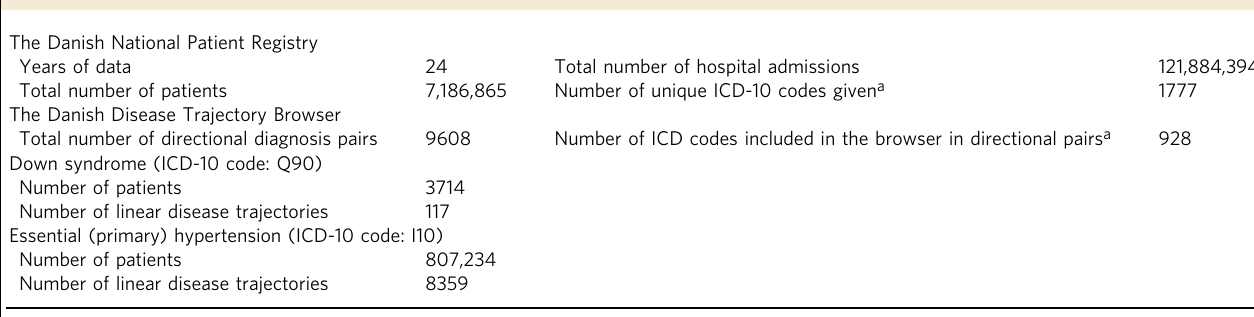
displays search results either as linear disease trajectories or as a disease trajectory network (e.g. Figs. 2 and 3). For quick queries and overview, it is recommended that users turn on the network view, which will be fastest and also appropriate for subsequent adjustment of search fi lters. In DS ( n = 3714 patients) and HT ( n